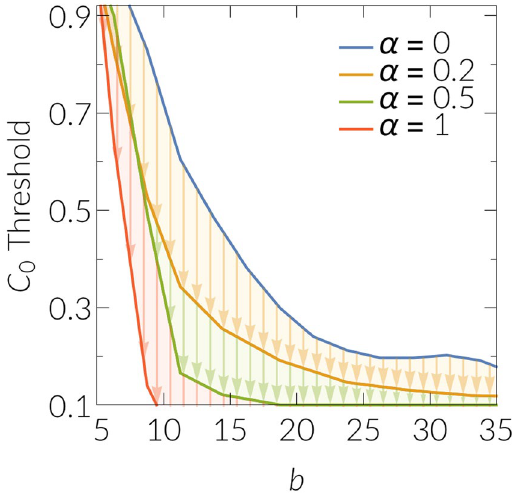
Figure 4. Mitigation effect for the spread of cooperation when hubs are preferentially selected as initial cooperators. Here, we have used synthetic networks constructed as before with 10000 nodes, a power law degree distribution with exponent γ = 2.5, temperature T = 0.4, and mean degree < k > ≈